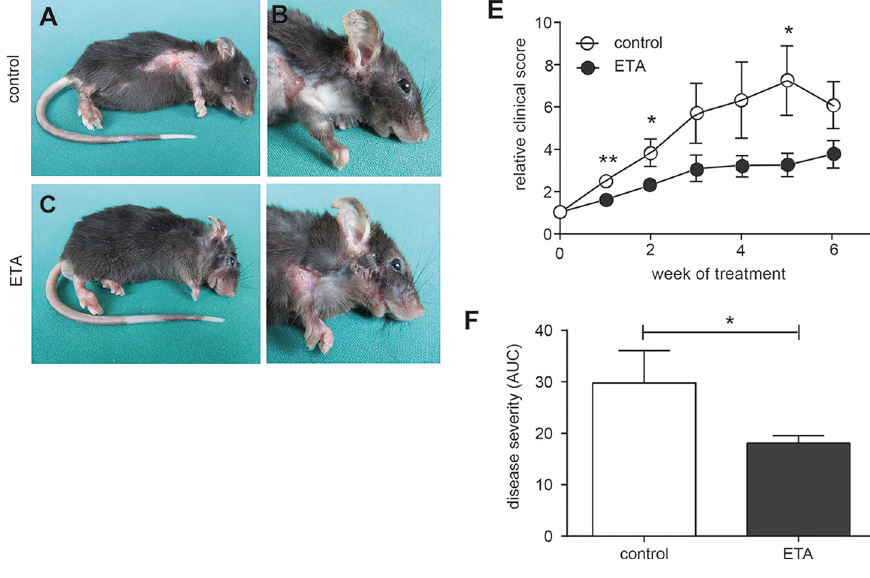
Figure 5. Therapeutic application of ETA improved disease severity in immunization- induced EBA. Three to six weeks after B6.S mice were immunized with mCOL7C-GST in TiterMax, mice developed clinical disease with more than 2% affected skin and were allocated into either the PBS (n = 7) or ETA (n = 8) treatment group. Representative clinical pictures of mice at 6 wks of treatment that received (A,B) PBS or (C,D) ETA every second day for 6 wks. (E) Time course of clinical disease development, shown as percentage of body surface area affected by blistering and (F) as area under the curve calculated over time for the entire treatment period of 6 wks (* p < 0.05, ** p <